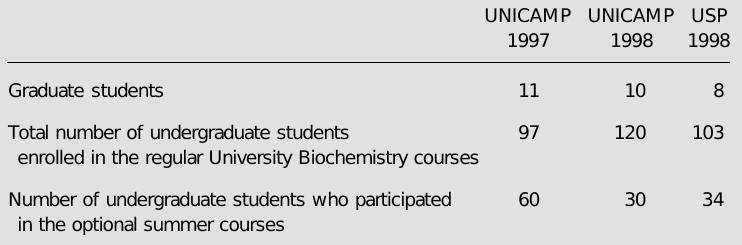
Table 5 - Number of participants in the summer